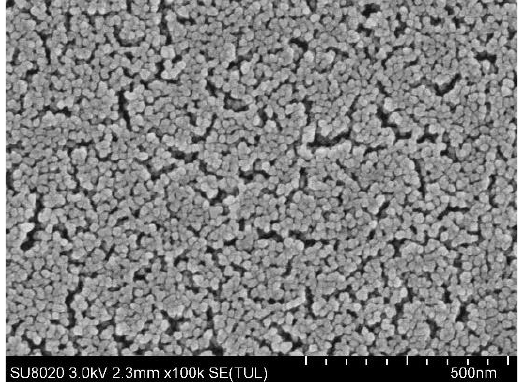
Figure 2. SEM image of fabricated SiO 2 nano-particles utilizing Stober method.